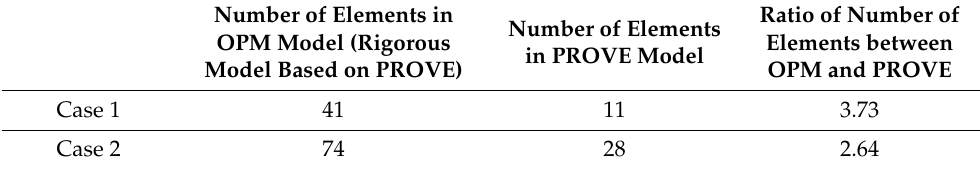
Table 3. Summary of